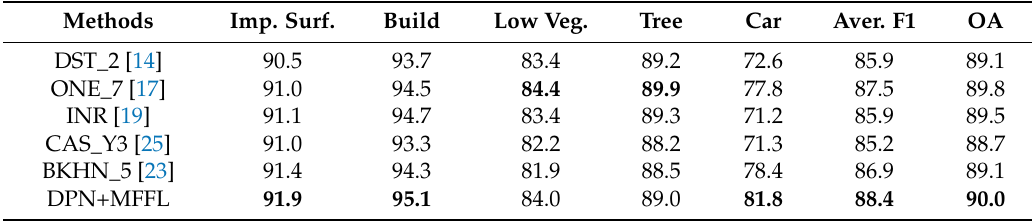
Table 2. Experimental results on the (ISPRS) Vaihingen challenge online test